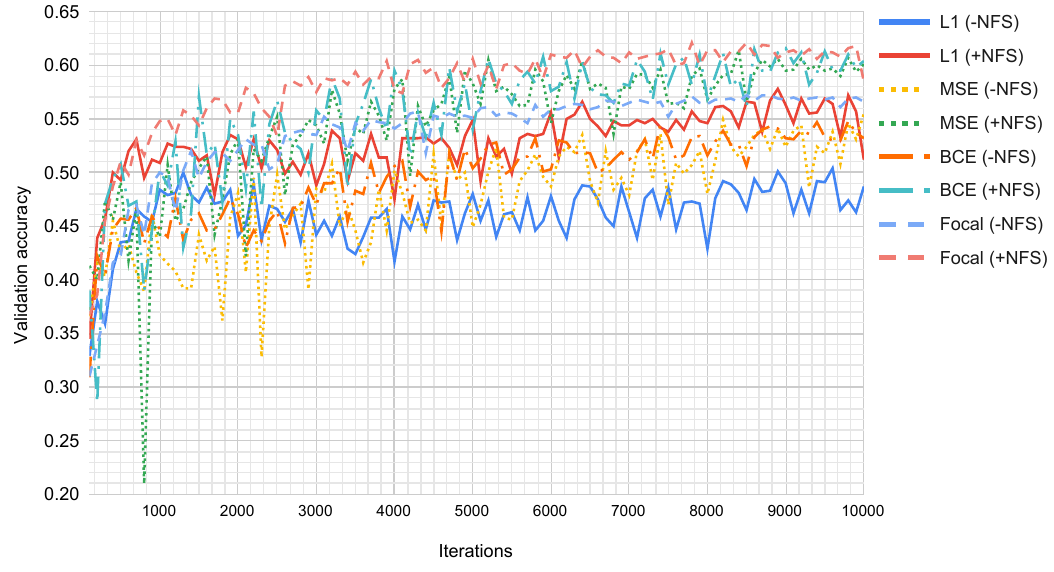
Figure 7. Trends in validation accuracy values over different